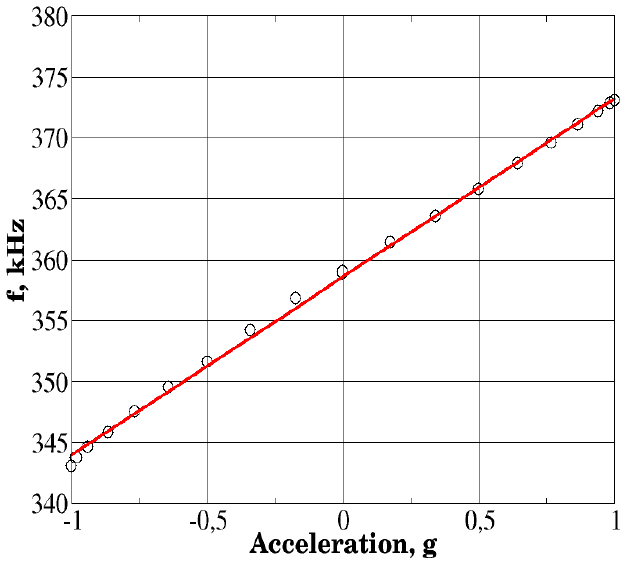
Figure 16. Dependence of the output frequency of the device on the applied acceleration.